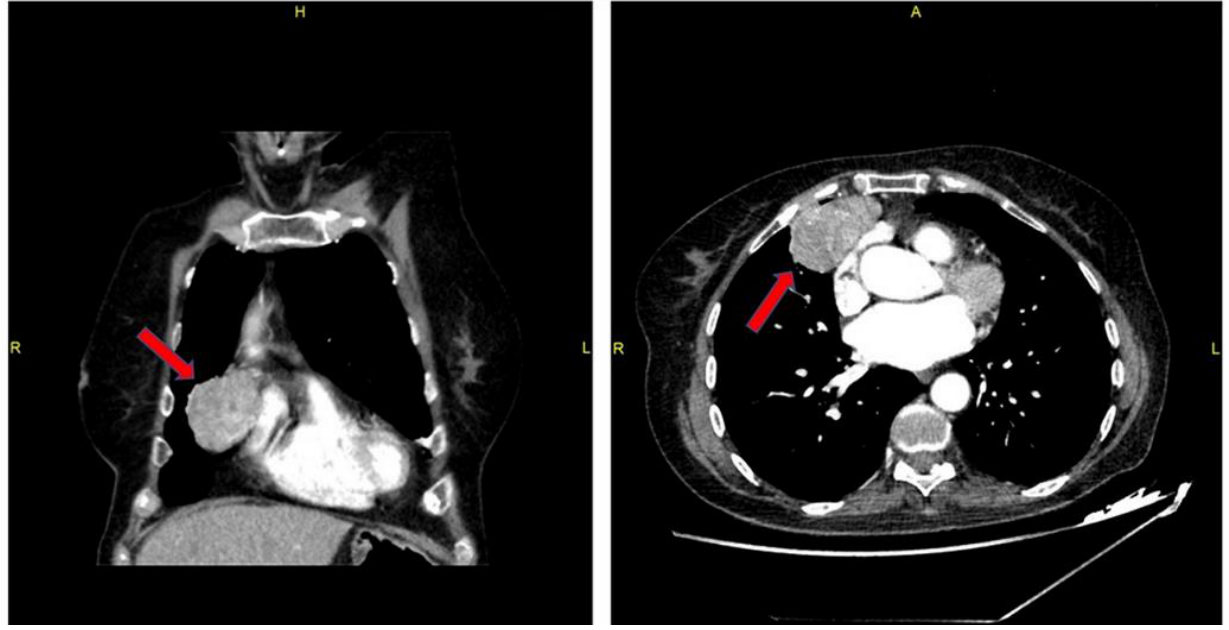
Figure 2 : Anterior and inferior prevascular mediastinal solid mass compatible with Type A thymoma. No obvious or gross mediastinal lymph